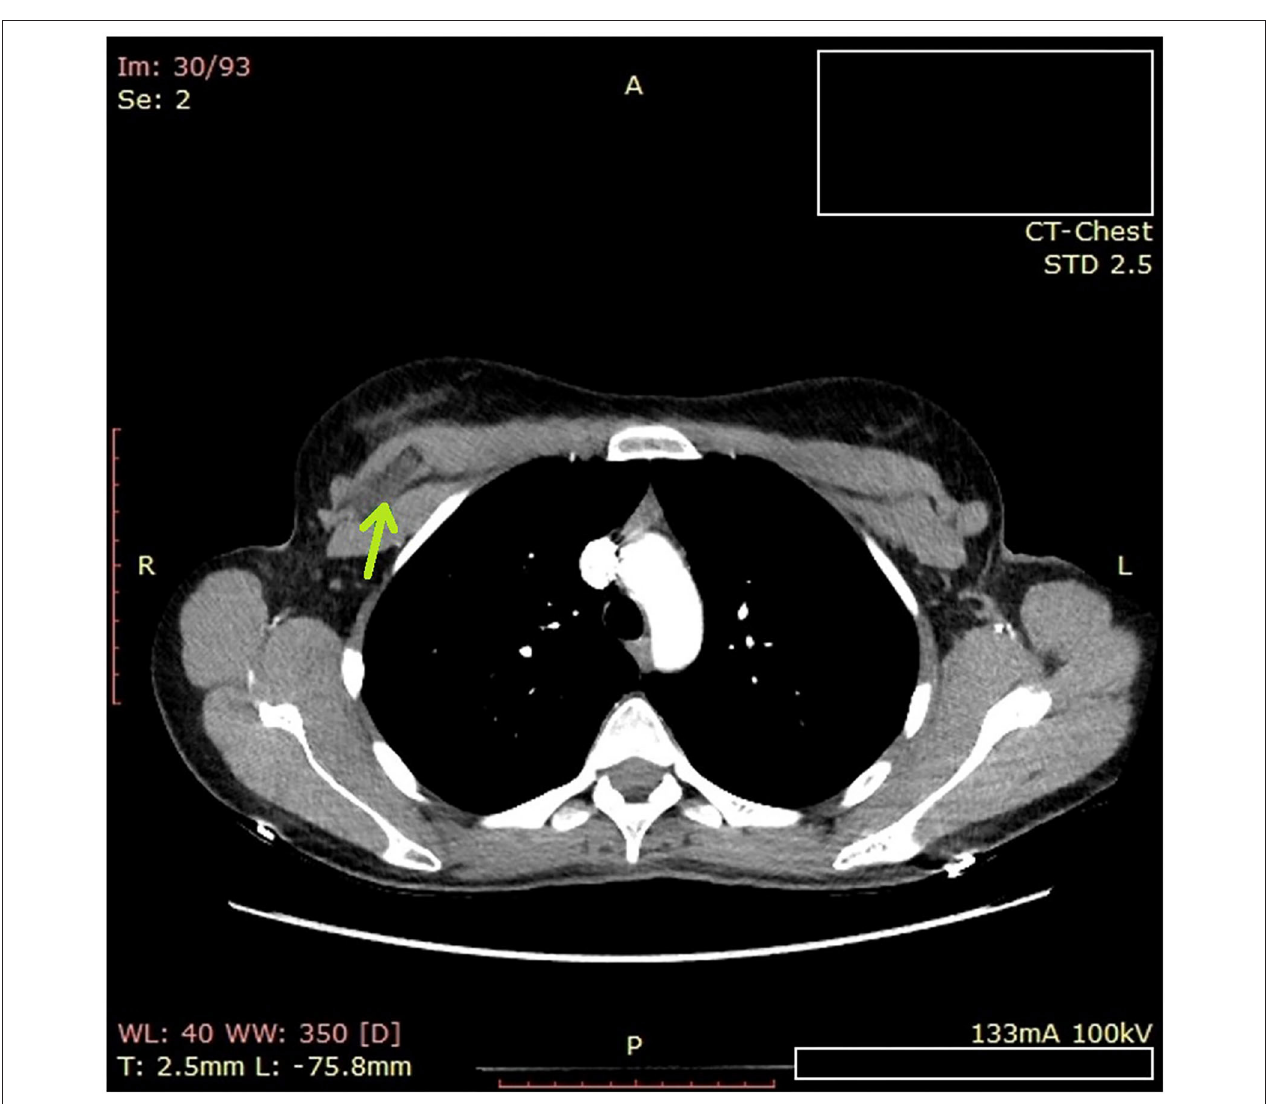
FIGURE 3 | Computed tomography (CT) of the chest. On the upper right chest wall behind the pectoralis muscle, a foreign object 2.7cm long by 1cm in diameter.